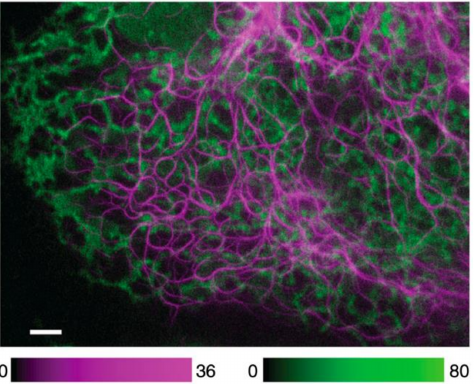
Figure 3. Red confocal/NIR STED dual-color imaging. VIM-SNIFP (magenta) was recorded in STED mode, and the ER targeted mCherry (green) in confocal mode. Scale Bar: 2 µ m. Material drawn from